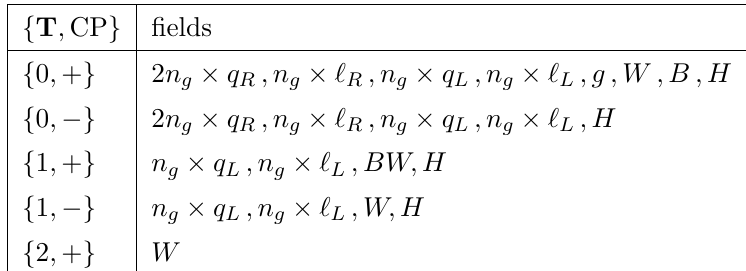
Table 1 . The 52 PDFs required for the SM evolution can written in a basis with de(cid:12)nite conserved quantum numbers. (5 n g +4) PDFs contribute to the f 0 ; + g state, (5 n g +1) to the f 0 ; (cid:0)g , (2 n g +2) to each to the f 1 ; + g and f 1 ; (cid:0)g and 1 to the f 2 ; + g , where n g = 3 stands for number of generations.